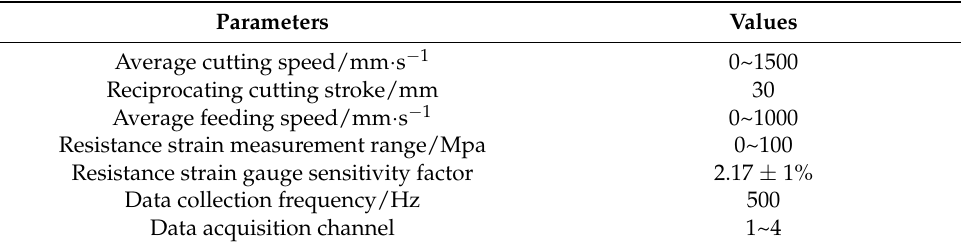
Table 4. Parameters of the reciprocating cutting test system.